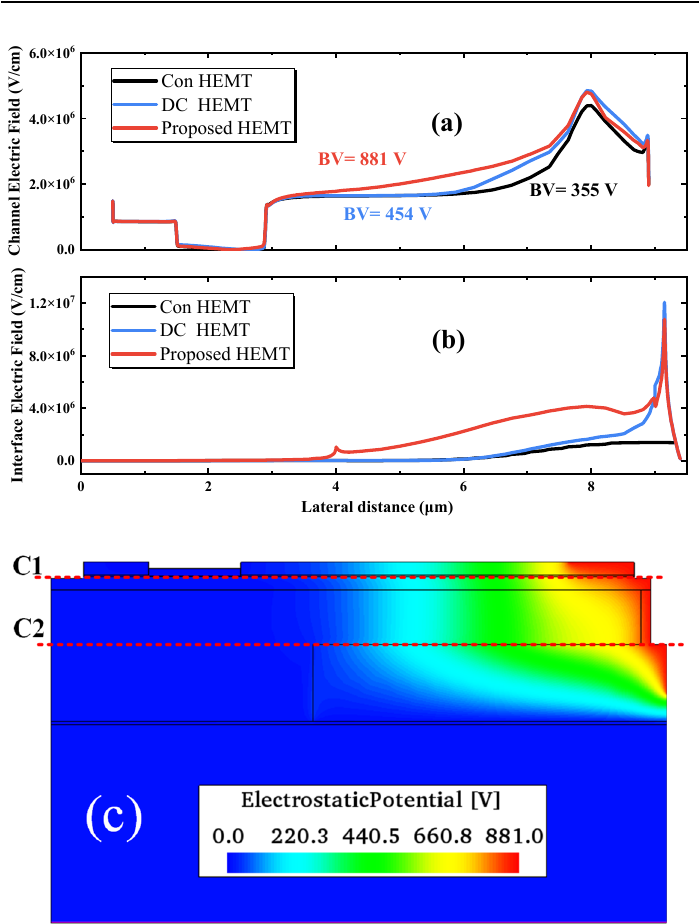
Figure 3. Simulated lateral electric field profile at the ( a ) channel and the ( b ) interface of the AlGaN buffer layer and buried Si 3 N 4 . ( c ) The specific cutlines along the device and the electrostatic potential distribution of the proposed HEMT.